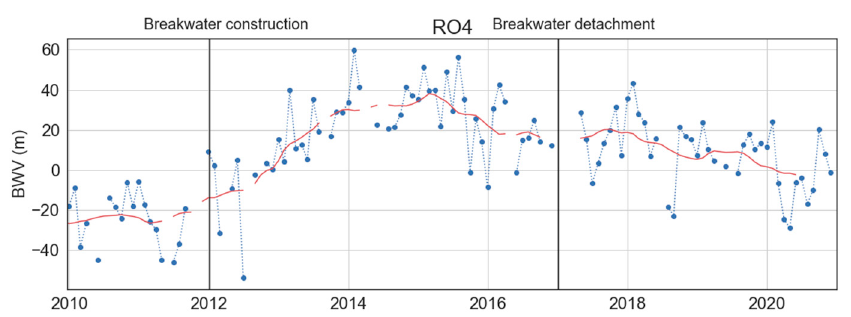
Figure 9. Monthly BWV (blue dots) and smoothed BWV series (red line) at RO4. The start of breakwater construction and the disconnection of the last breakwater are indicated by black lines.